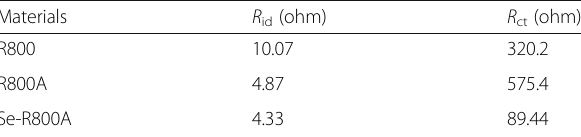
Table 2 The resistance values were obtained by modeling the equivalent circuit for experimental impedance